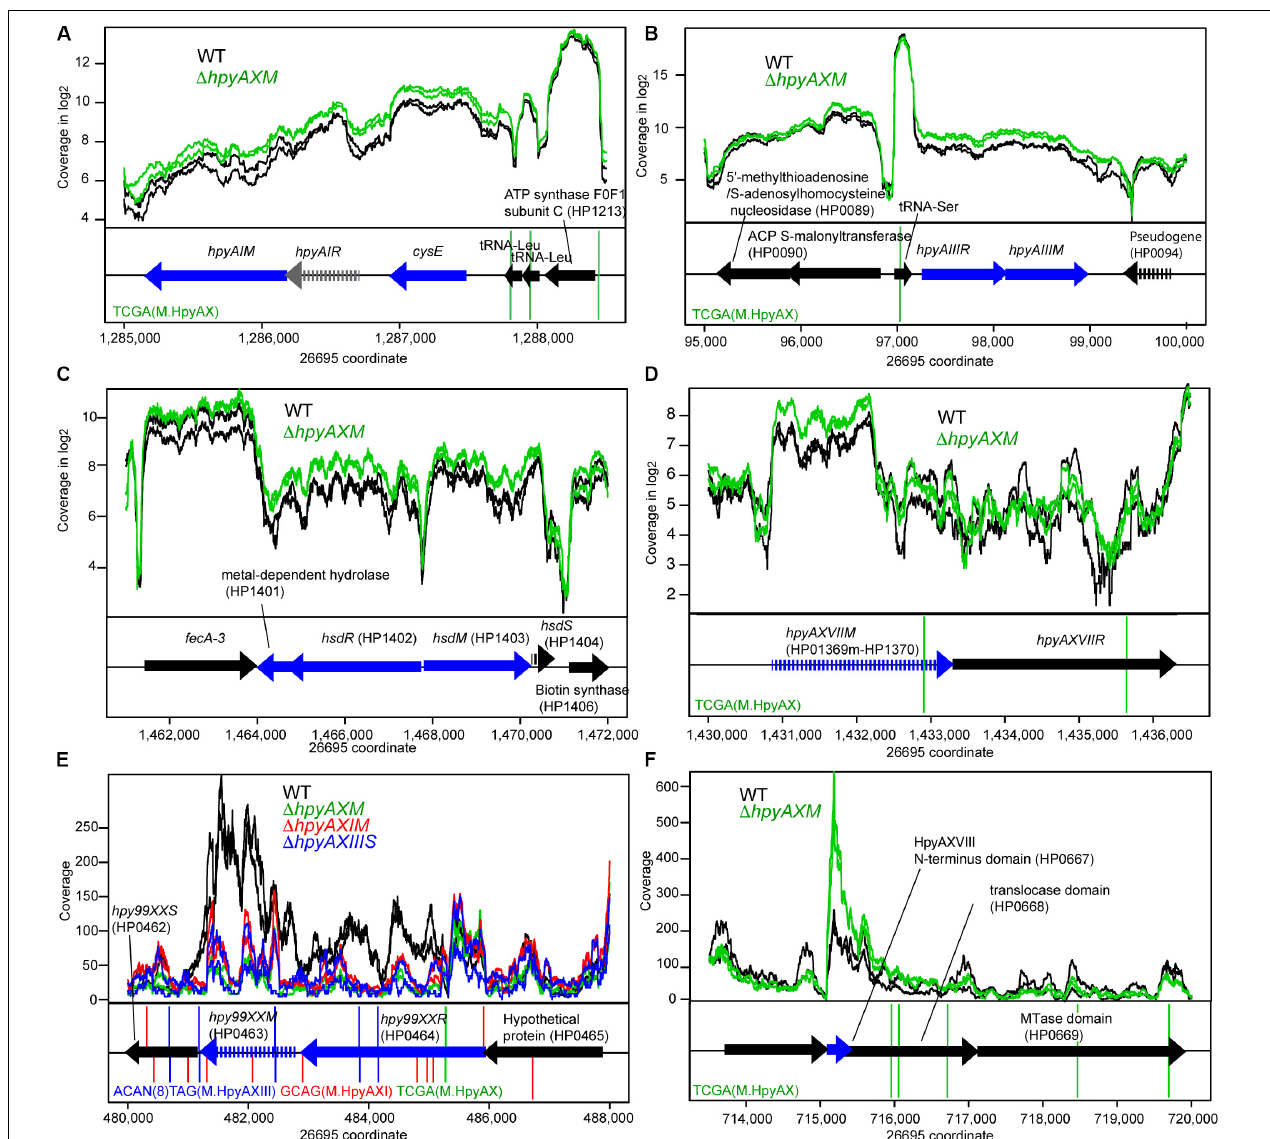
FIGURE 3 | Effects of methyltransferase knockouts on transcript level of several methyltransferase loci. (A) HpyAI locus. (B) HpyAIII locus. (C) HP1403 locus. (D) HpyAXVII locus. (E) Hpy99XX homolog locus. (F) HpyAXVIII locus. The parental strain is 26695. Except for (E,F) , read coverage is shown in logarithmic scale. A blue arrow indicates a differentially expressed gene. A vertical line indicates a copy of methylation motif. A broken arrow indicates a pseudogene. The transcripts are from both strands as RNA-seq for strain 26695 was carried-out in “non-stranded”